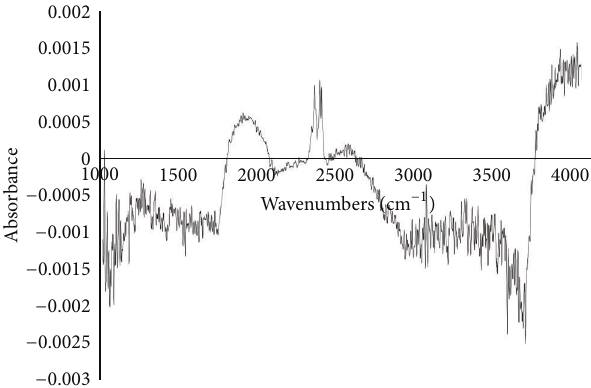
Figure 5: FT-IR spectrum of H. discus hannai